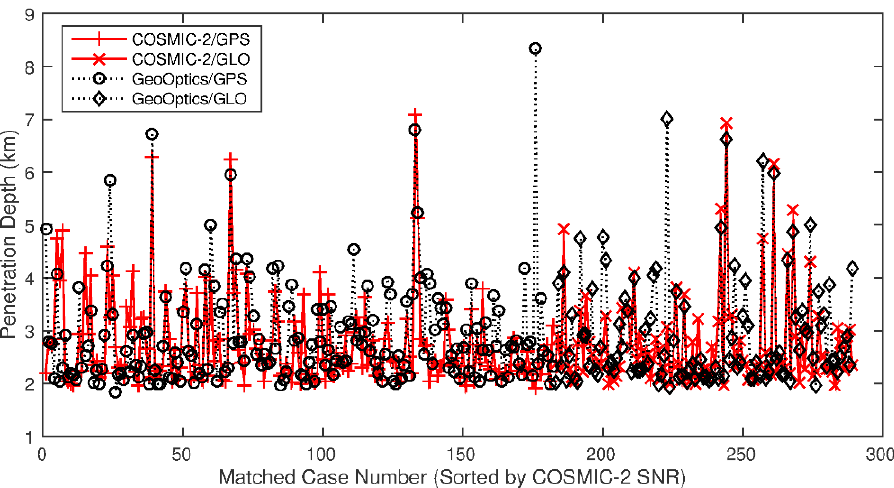
Figure 11. Penetration depth comparison for the SRO pairs between COSMIC-2/GPS (red solid plus line) and GeoOptics/GPS (black-dotted circle line) as well as between COSMIC-2/GLONASS (red solid cross line) and GeoOptics/GLONASS (black-dotted diamond line).